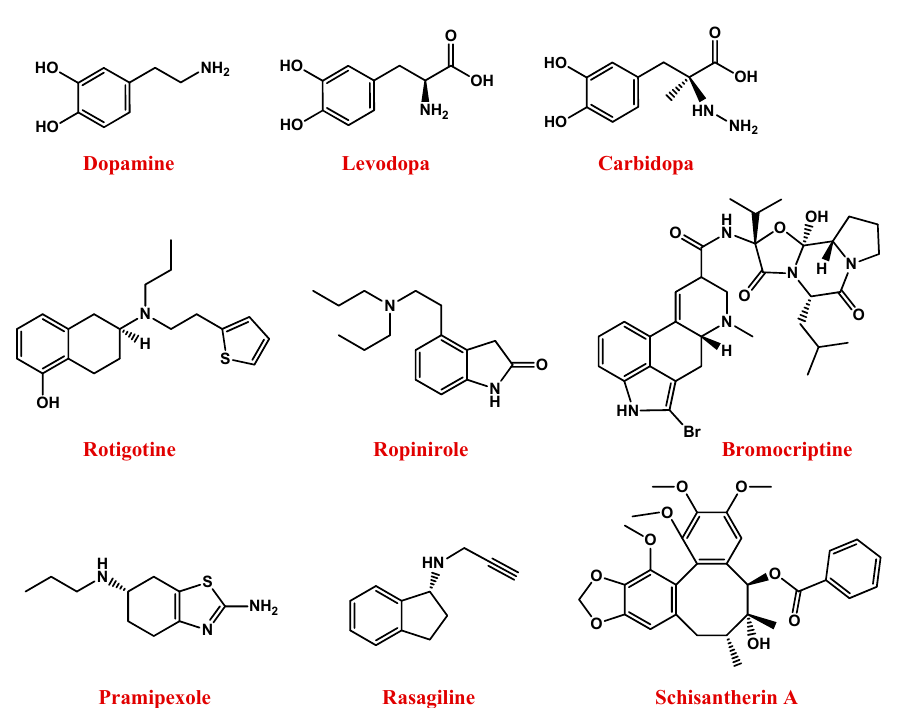
Figure 2. Molecular structures of main anti-PD drugs.